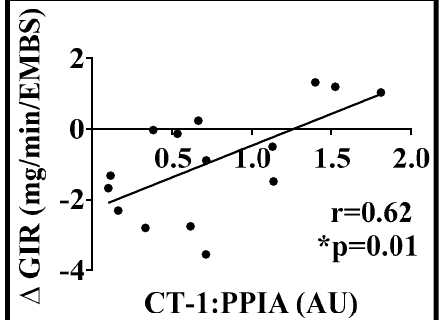
Figure 4. CT-1 scABD adipose expression is positively correlated with the change in GIR with 40% overfeeding in men. Simple associations between baseline scABD CT-1 expression and changes in insulin sensitivity in response to overfeeding were analyzed using Pearson’s correlation ( N = 15). The hyperinsulinemic euglycemic clamp was used to assess glucose infusion rate (GIR) in the men. GIR with high-dose insulin infusion (50 mU/min/m 2 ) was calculated and expressed as milligrams per minute per estimated metabolic body size (EMBS)). The Pearson’s correlation between CT-1 expression and the change in GIR is 0.62 ( p = 0.01).